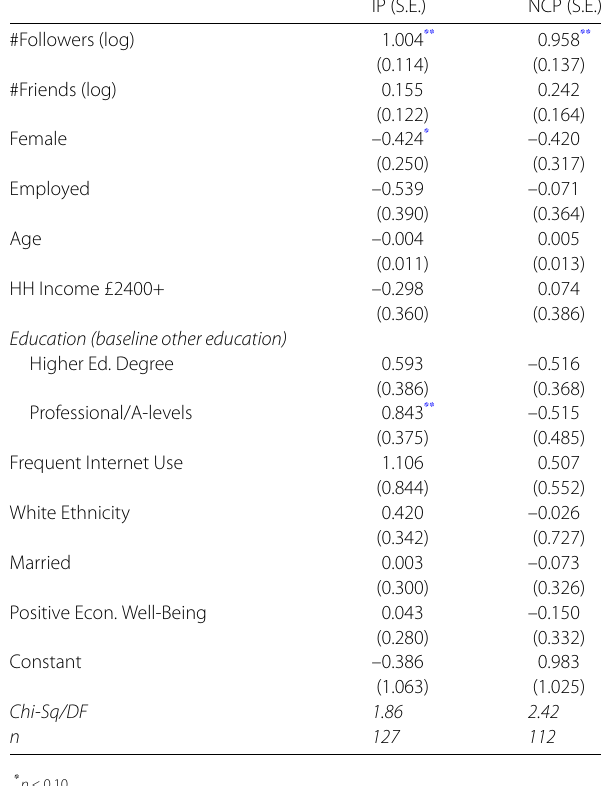
Table 3 Prediction of Number of Total Twitter Posts